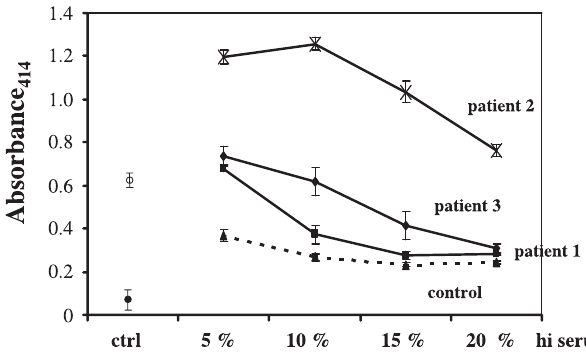
Figure 4. Defective Protective Activity with CFHR1/CFHR3 Deficient Plasma A novel type of hemolytic assay was used to analyze hemolytic activity of CFHR1/CFHR3 deficient human serum. Sheep erythrocytes were incu- bated with factor H–depleted human plasma. Sheep erythrocytes generally act as nonactivators of complement in human plasma. However, depletion of factor H from the plasma converts the sheep erythrocytes into activator surfaces (ctrl, empty circle). Addition of heat inactivated serum to depleted plasma as a source of factor H has a dose- dependent protective effect ( ‘‘ control ’’ ). Compared to normal human serum, sera of patient P1 to P3 with CFHR1/CFHR3 deficiency showed less protective activity as indicated by the increased lysis of erythrocytes. The classical pathway of complement activation was inhibited by the chelating agent EGTA. Erythrocytes incubated in buffer do not lyse (ctrl, filled circle). Mean values and standard deviations of three separate experiments are shown.